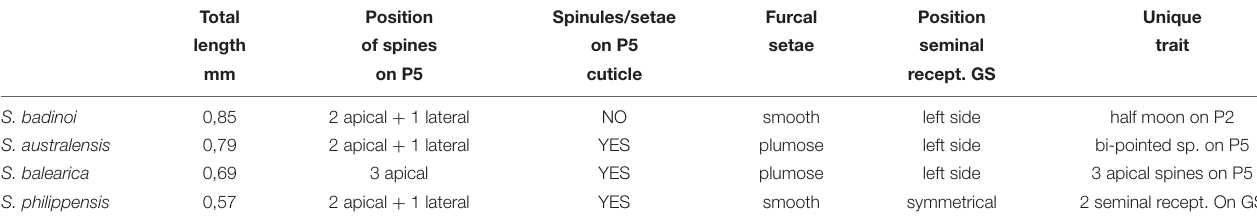
TABLE 1 | Morphological comparison of the main distinguishing features between S. badinoi n.sp. and the other Stygocyclopia species (only females). Total Position Spinules/setae Furcal Position Unique length of spines on P5 setae seminal trait on P5 cuticle recept. GS